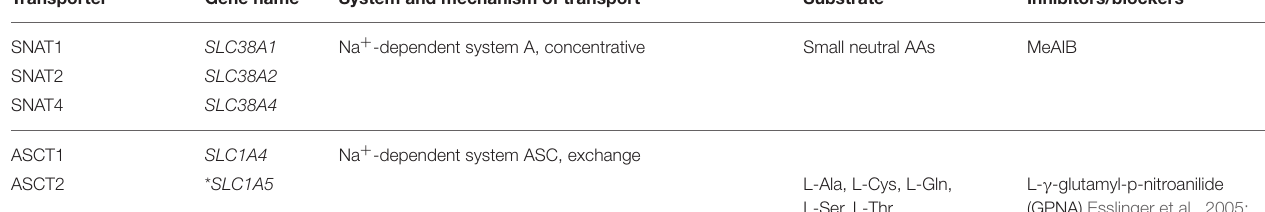
TABLE 1 | Summary of AA transporters.